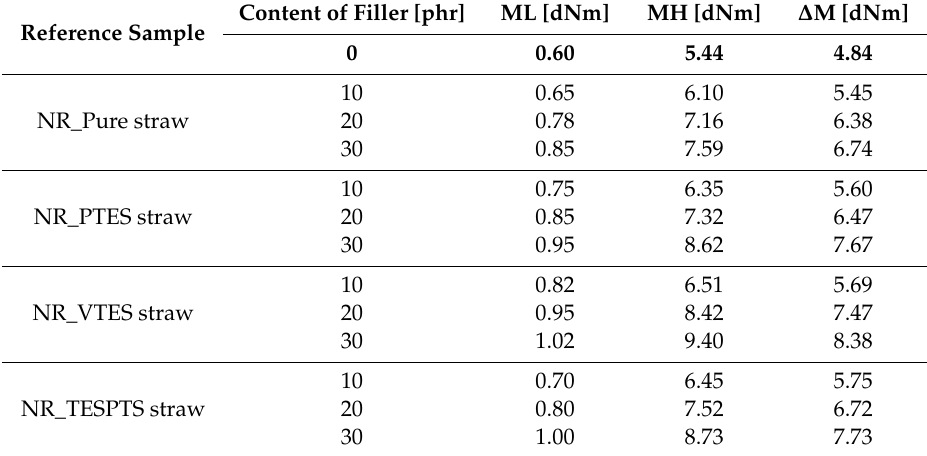
Table 2. Rheometric properties of natural rubber composites filed with: -pure straw (NR_Pure straw); -straw modified with propyltriethoxysilane (NR_PTES straw); -straw modified with vinyltriethoxysilane (NR_VTES straw); -straw modified with 3,3 (cid:48) -Tetrathiobis(propyl-triethoxysilane) (NR_TESPTS straw). Reference